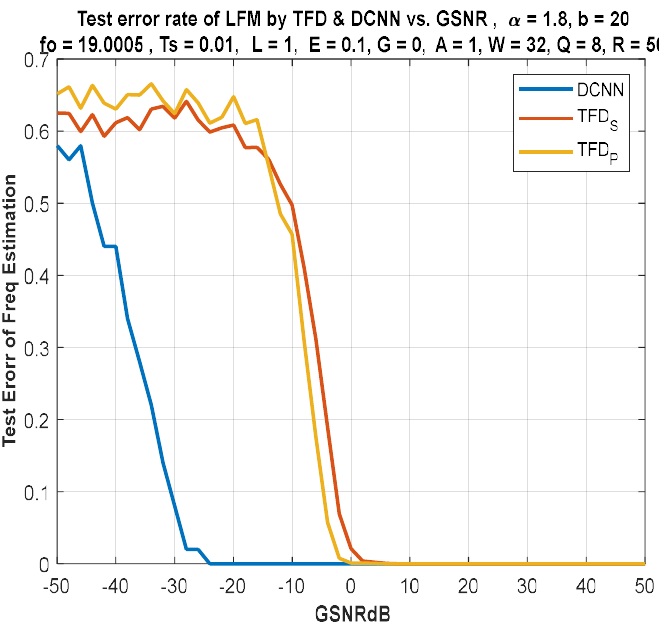
Figure 32. The error rate of FE for noisy LFM (AWGN and S α SN) by DNN and TFD for spectrogram (TFD s ) and pspectrum (TFD p ).